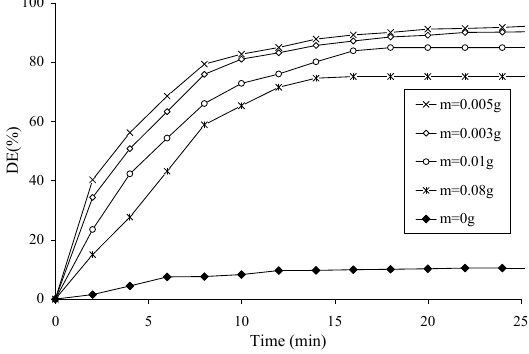
Fig. 4: Effect of catalyst mass on NBB oxidation (pH=3, [C Figure 4: Effect of catalyst mass on NBB oxidation (pH=3, [C i ]= 30mg/L, [H 2 O 2 ]=0.005mM).